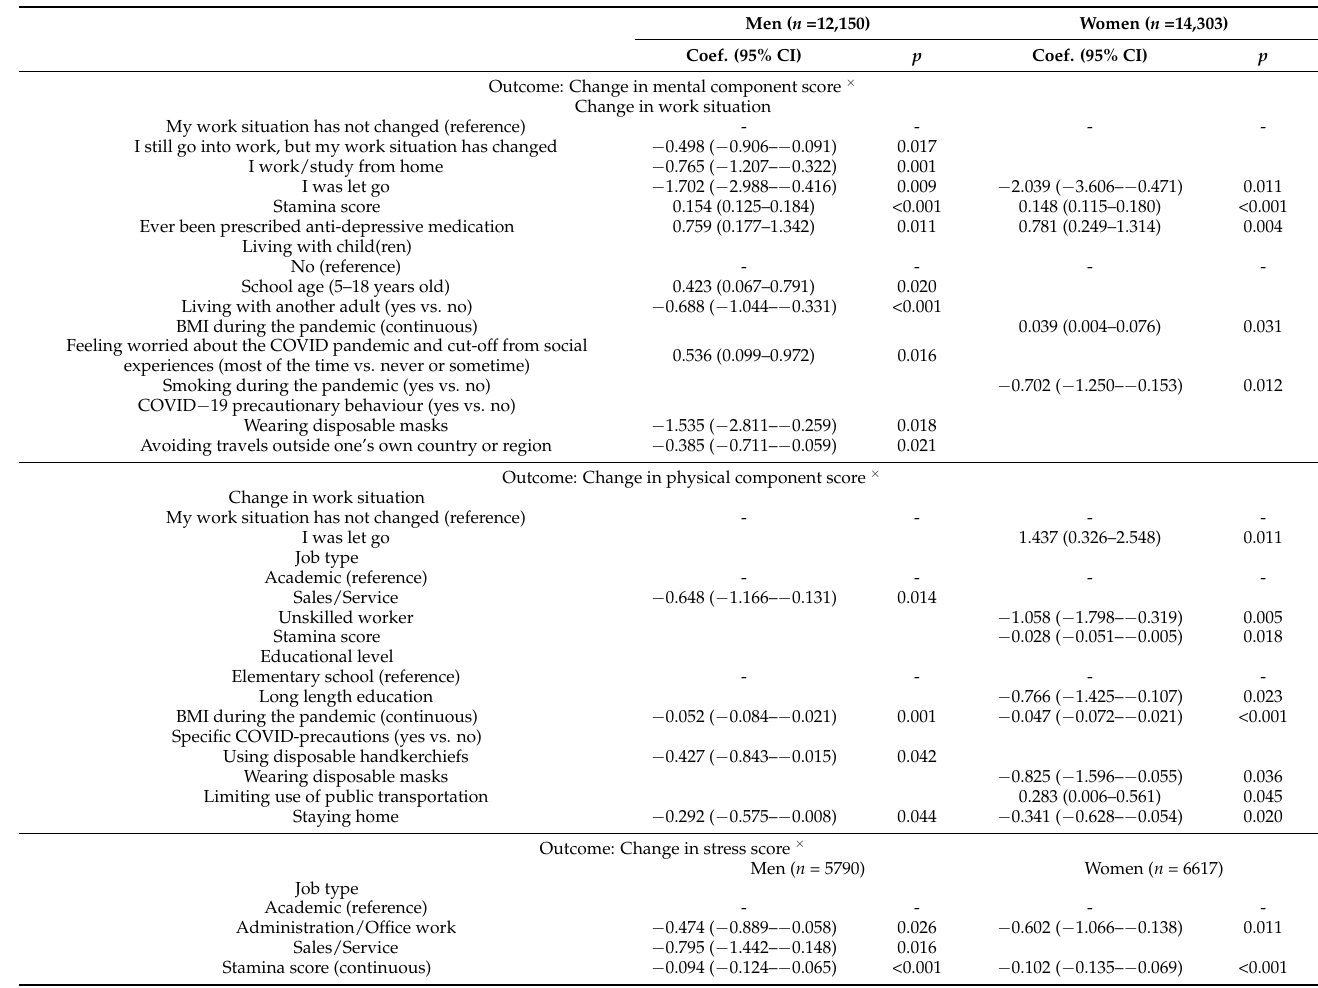
Table 3. Linear regression analyses. Identification of characteristics associated with decrease or increase in mental or physical health characteristics (displaying risk estimates for covariates with a p value < 0.05 in the complete model). Men ( n =12,150) Women ( n =14,303) p Outcome: Change in mental component score × Change in work